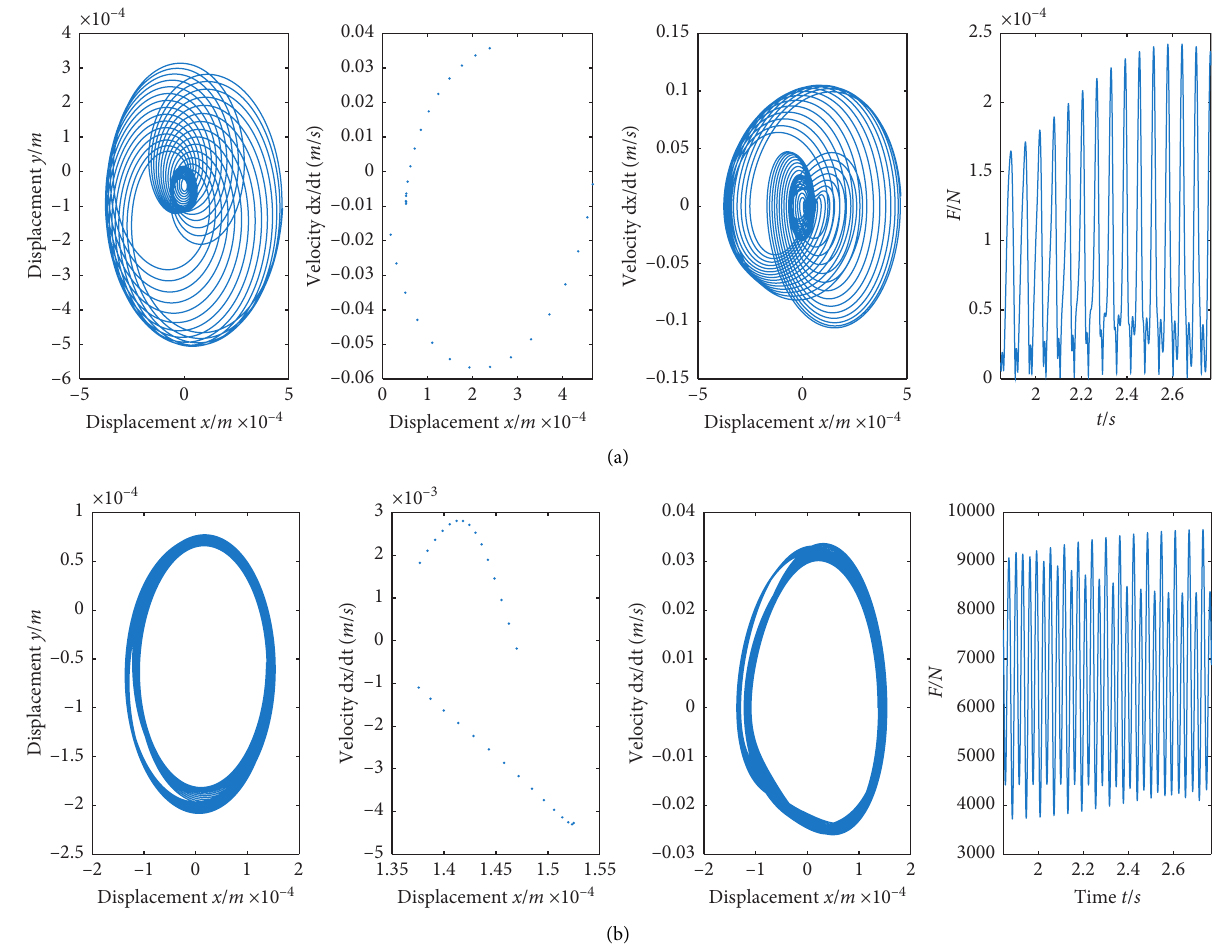
Figure 10: The rotor operating state diagram under different demagnetization states at ω � 204 . 2033rad/s. (a) Demagnetization states ζ � 60% and β � ( π /15 ) . (b) Demagnetization states ζ � 30% and β � ( π /3 )